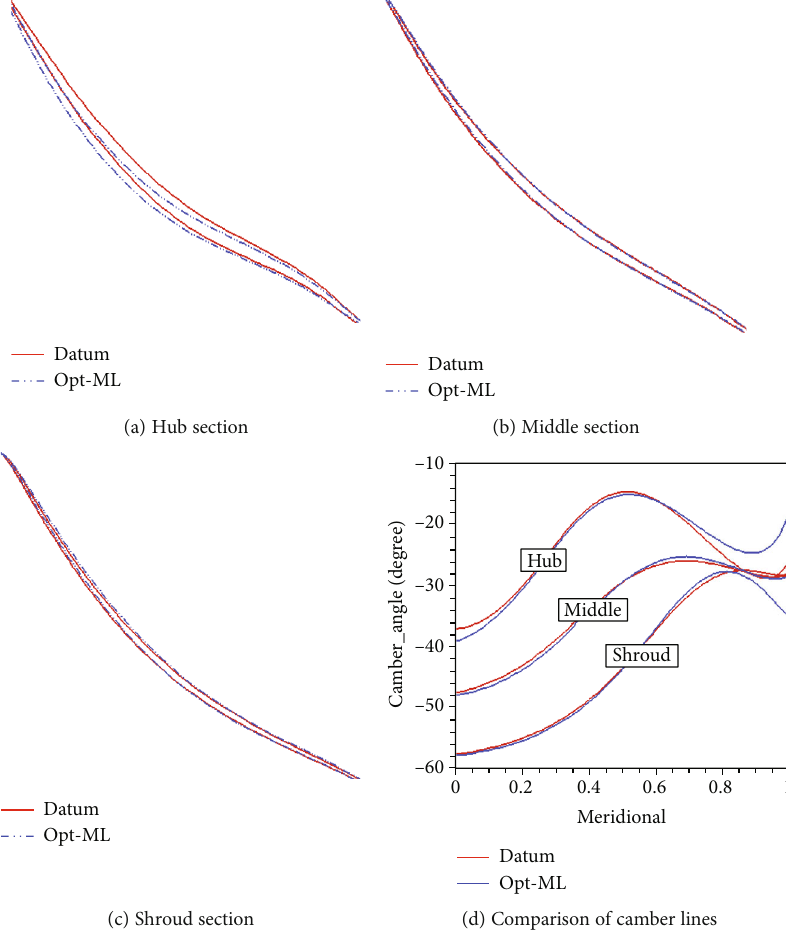
Figure 11: Comparison of the impeller